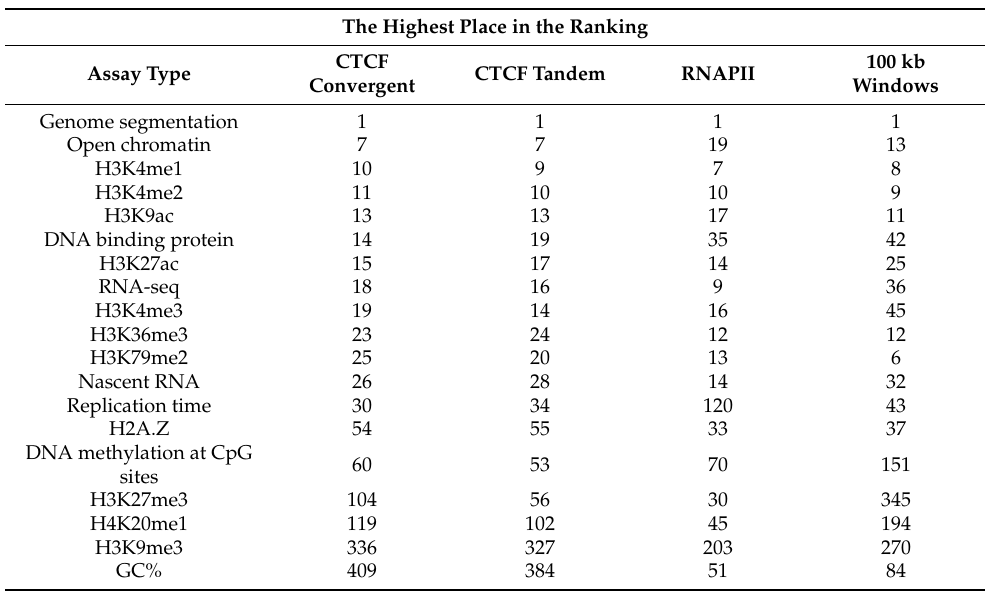
Figure 2. Top decile of the most important features for classification of CTCF convergent loops into compartments. Table 2. The highest position in the ranking of different genomic marks for loops and genomic windows. All DNA binding proteins are represented together